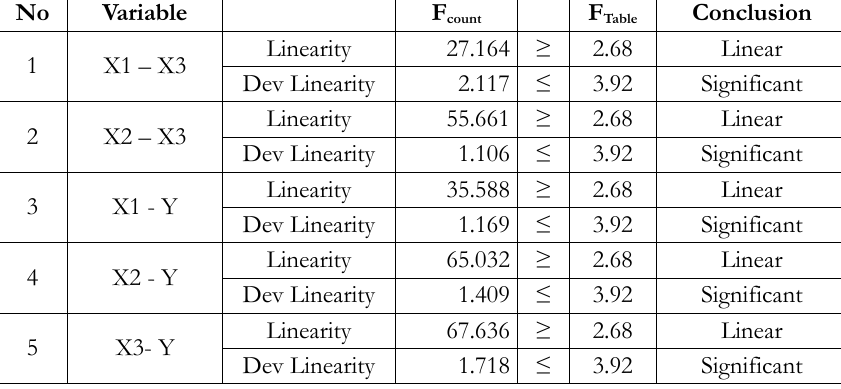
Table 5. Calculated F value data for linearity test among variables